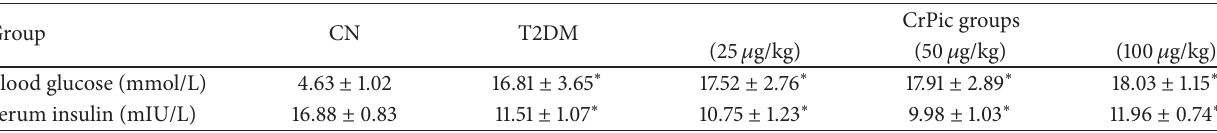
Table 2: The blood glucose and serum insulin concentrations of the rats after the blood glucose levels were stably maintained for one week.